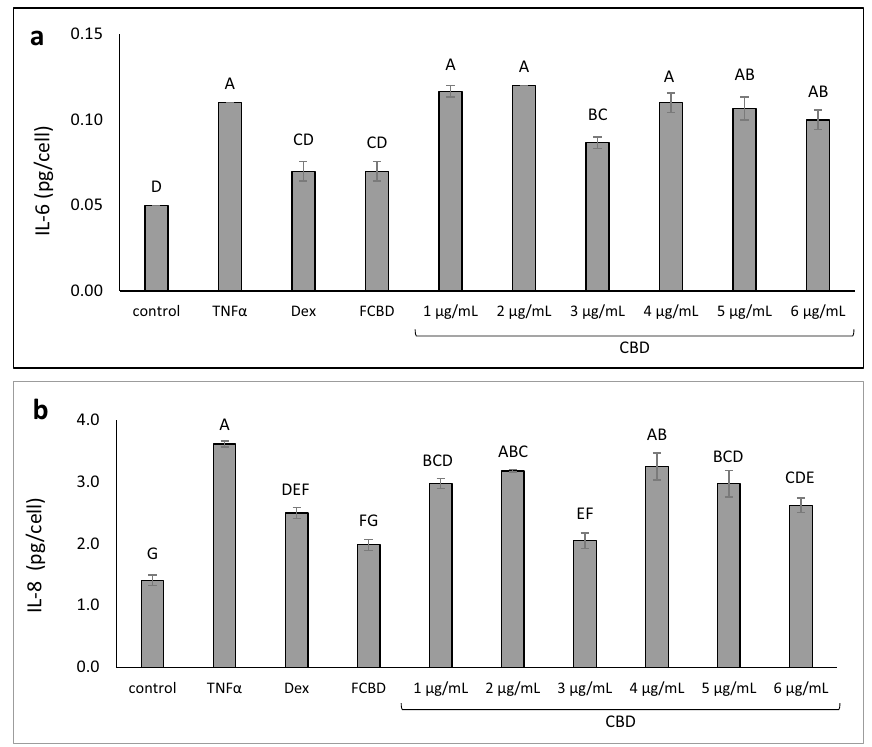
Figure 2. The level of ( a ) IL-6 and ( b ) IL-8 in A549 cells treated with F CBD and CBD. Cells were treated with 300 ng/mL TNFα, 4.1 μg/mL F CBD (FCBD) and CBD at different concentrations for 4 h. Dexamethasone (Dex; 4 μg/mL) served as a positive control. Control (0.6% v/v methanol) treatment served as the solvent (vehicle) control; TNFα is TNFα+ solvent control treatment. Error bars indicate ± sem (n = 3). Bars labeled with different letters are significantly different from all combinations of pairs according to the Tukey–Kramer HSD test ( P ≤ 0.05).